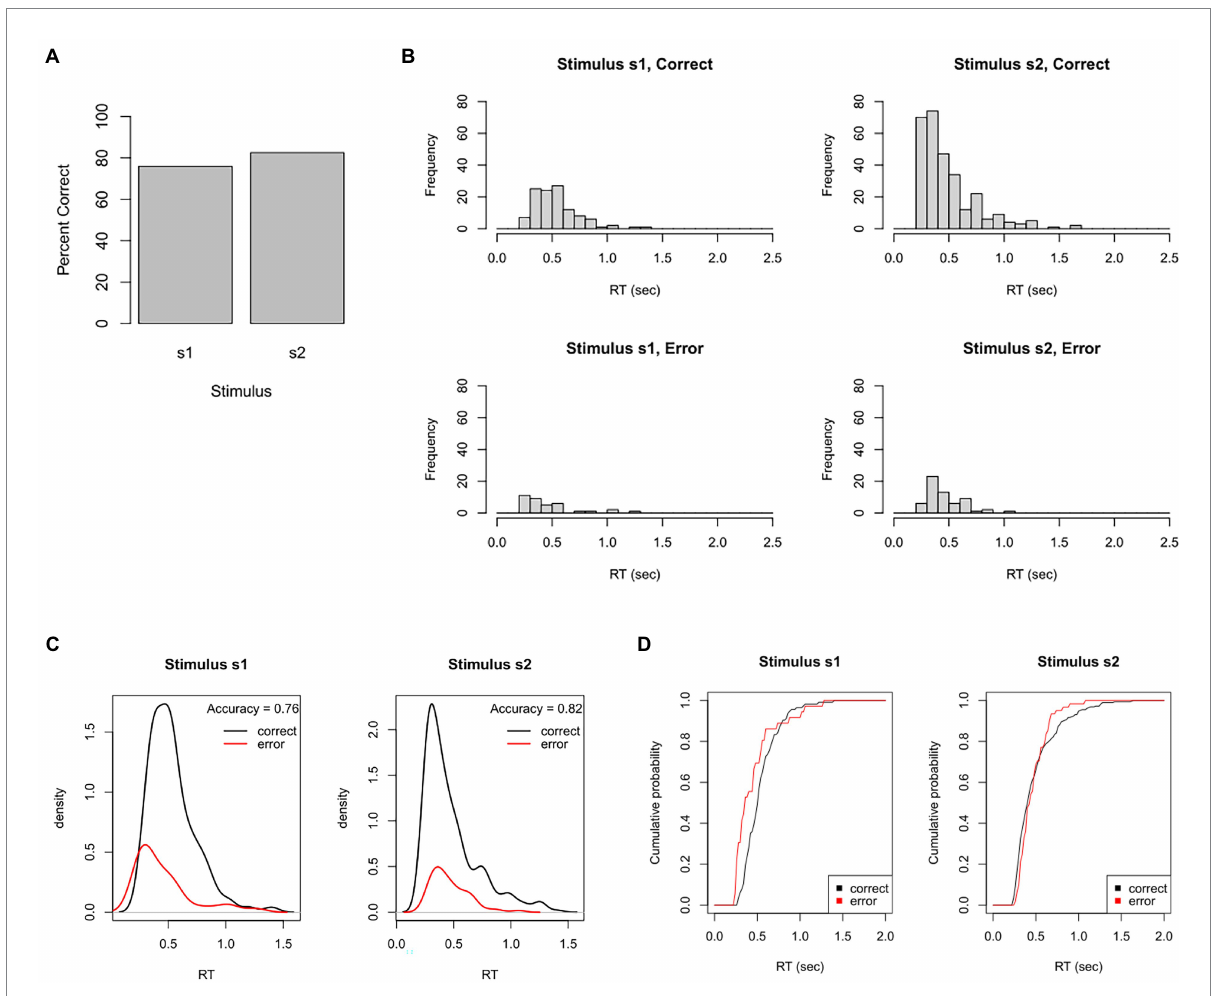
FIGURE 4 Test dataset. Here, the participant completed a task that intermixes 150 trials with stimulus s1 (correct response = r1) and 350 trials with stimulus s2 (correct response = r2). (A) In this example, the participant achieved 76% accuracy on s1 and 83% accuracy on s2. (B) Frequency histograms showing right-skewed RT distributions for each stimulus and response. (C) The RT data plotted as probability density functions (PDFs), in which height of the curve at any point on the x-axis reflects the probability of a response occurring at that RT. Here, PDFs are scaled so that the total area under the curves sums to one, resulting in “taller” PDFs for the more frequent correct than incorrect response. (D) The same data plotted as cumulative distribution functions (CDFs), showing the probability that a response has occurred at or before each RT; here, curves asymptote at about 2 s, showing that all RTs have occurred by that point. (C) Plotted using functions in the DMC package for